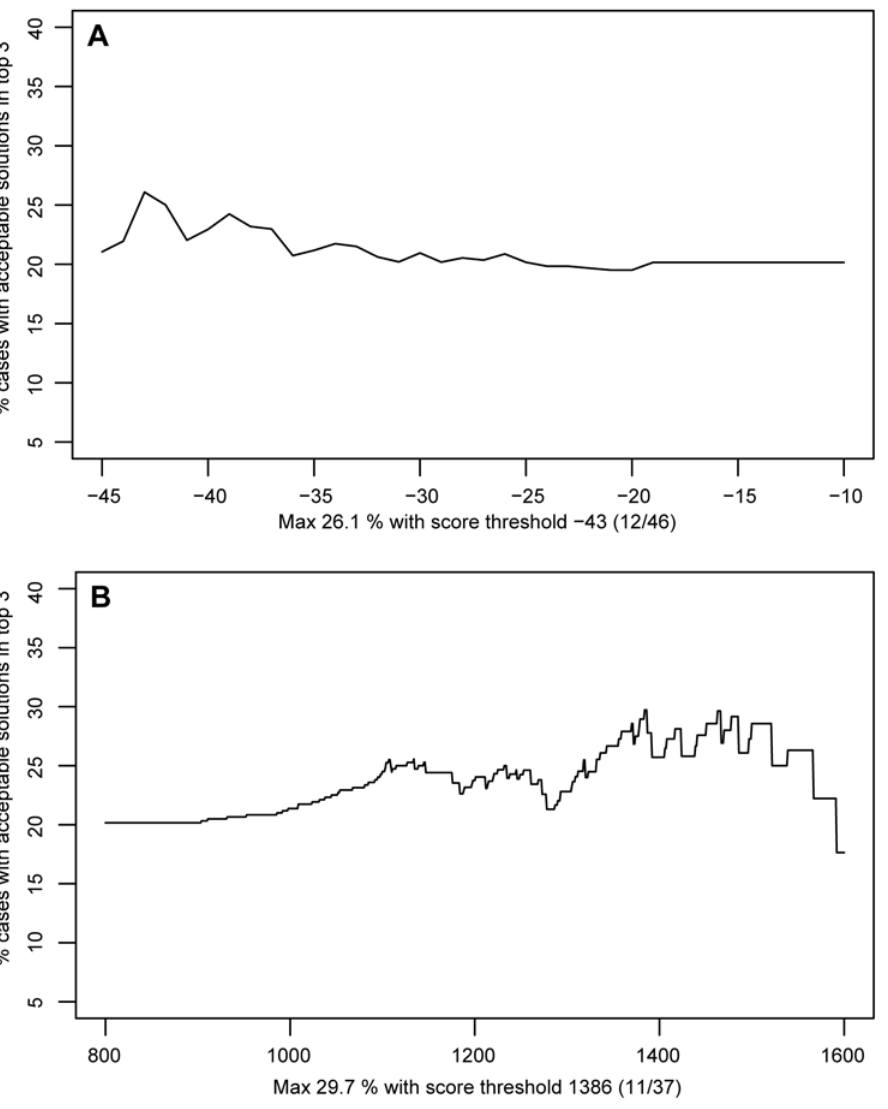
Figure 2. Success rate by using a threshold on the score. Ratio between the number of ‘‘good’’ cases (cases having at least one acceptable solution in the top 3) and the total number of cases satisfying the threshold for increasing values of the threshold. (A) refers to ZDOCK 3.0 + pyDock (without Van der Waals contribution) while (B) refers to ZDOCK 3.0 alone.